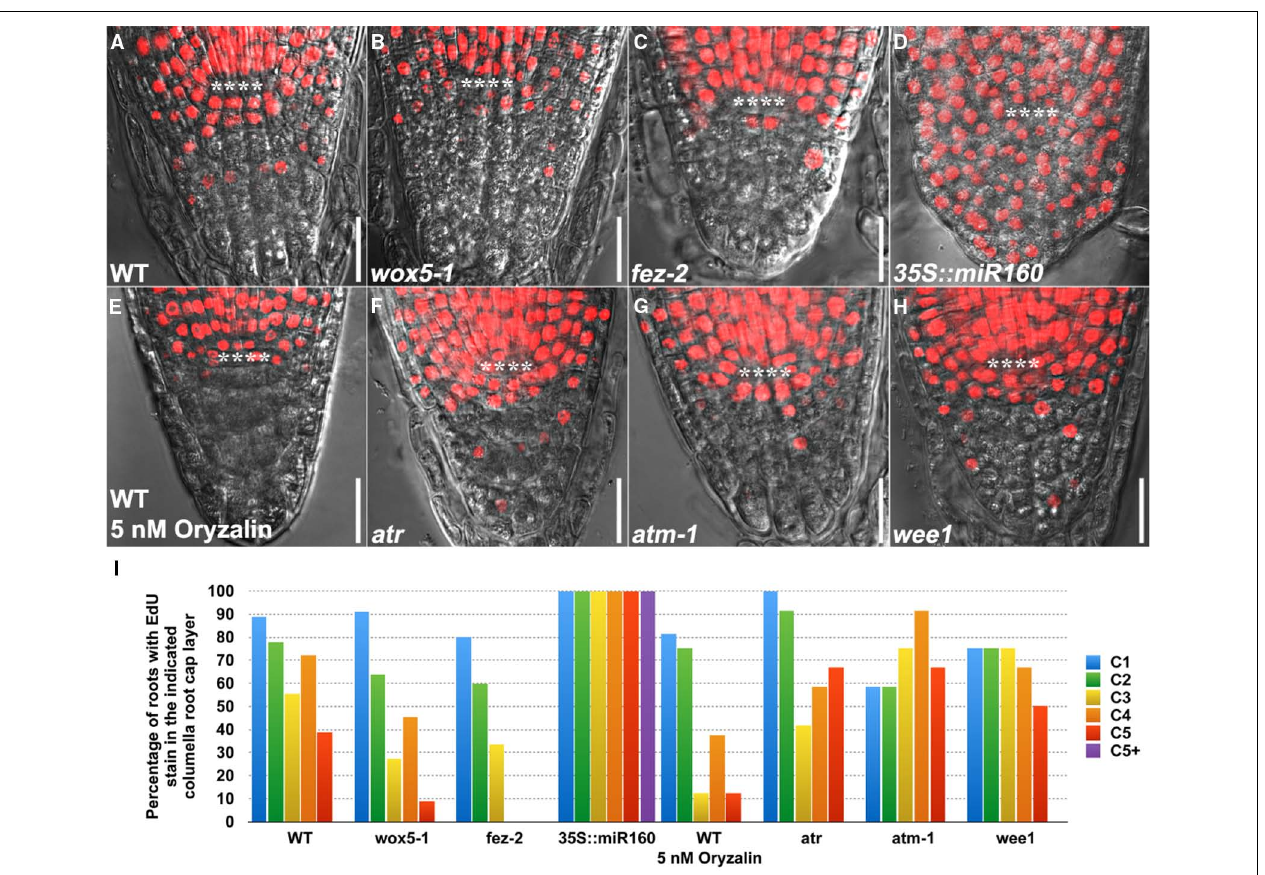
FIGURE 2 | EdU Staining patterns in the columella root cap of 4-day-old WT and mutant genotypes. (A) WT ( n = 18). (B) wox5-1 ( n = 11). (C) fez-2 ( n = 15). (D) 35S::miR160 ( n = 10). (E) WT treated with 5 nM oryzalin ( n = 16) for 24 h. (F) atr ( n = 12). (G) atm-1 ( n = 12) and (H) wee1 ( n = 12). All WT and mutant seedlings were treated with 10 m M EdU for 24 h before imaging. (I) Quantification of the percentage of roots with EdU stain in the indicated columella root cap layer. **** represents position of the QC. C1: 1st columella